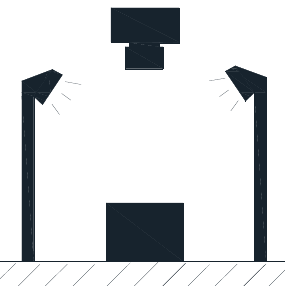
Figure 7. Specimen cross-section.